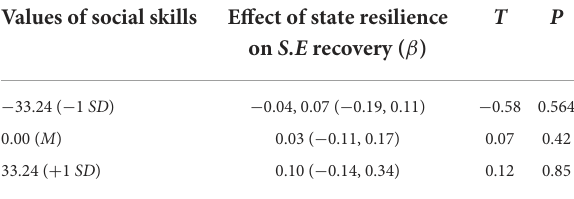
TABLE 4 Conditional effect of state resilience on recovery at different values of social